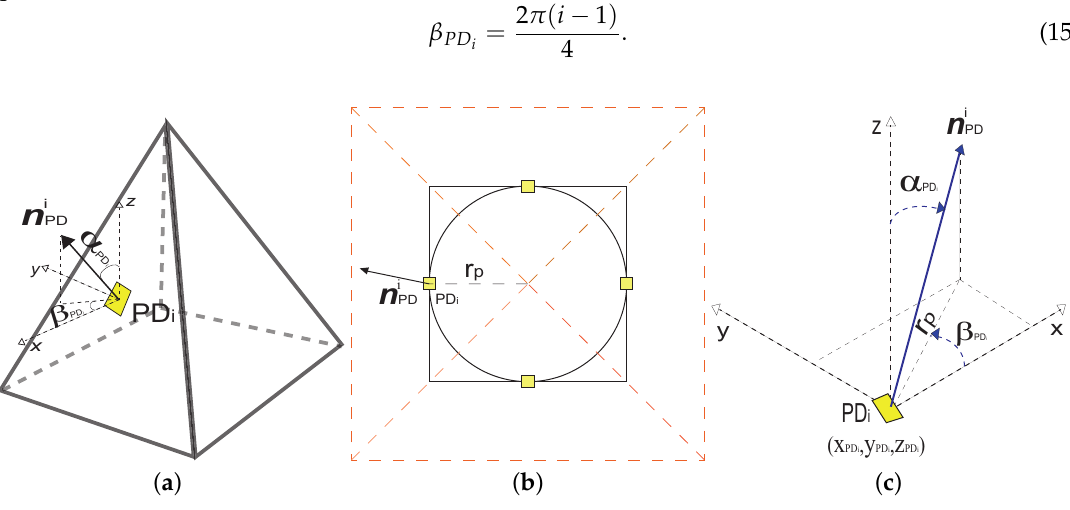
Figure 5. General structure of the pyramidal ADR. ( a ) Side view, ( b ) top view, and ( c ) coordinate system of the